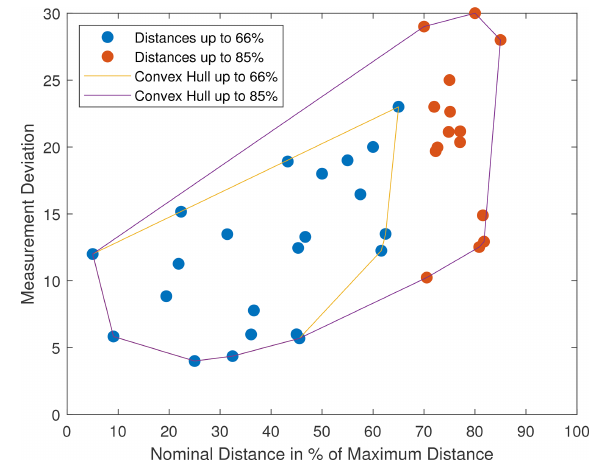
Figure 8. A scenario in which the convex hulls of the measurement points below 66% and of all measurement points (including above 66%) agree up until 66%. We assume that an MPE specification ac- cording to Eq. (3) based on the points below 66% would encompass the points above 66% as well.